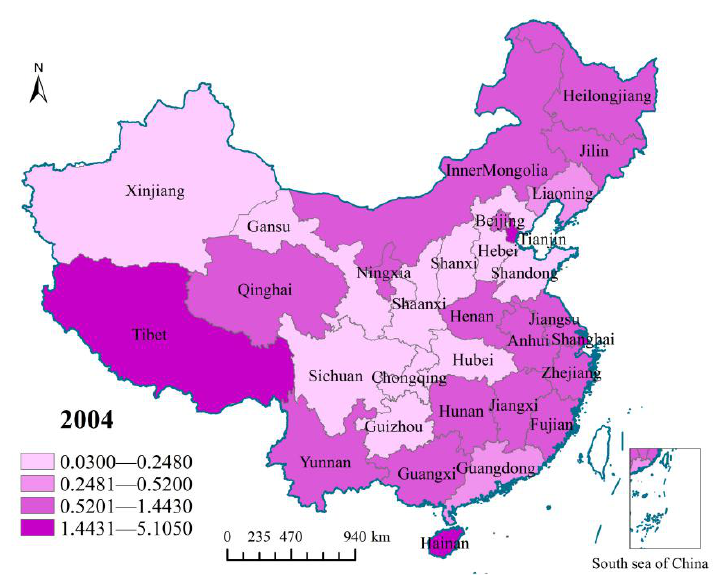
Figure 1. Distribution of forestry ecological efficiency (FEE) in China in 2004.